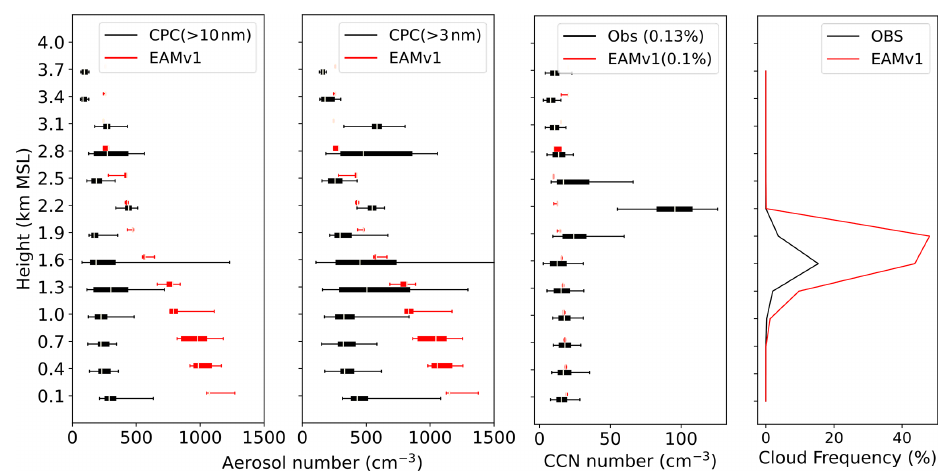
Figure 13. Vertical profiles of aerosol number concentration for diameters > 10 and > 3nm, CCN number concentration, and cloud frequency measured by the 16 February 2018 flight in ACE-ENA. The percentile box represents the 25th and 75th percentiles, and the bar represents the 5th and 95th percentiles.